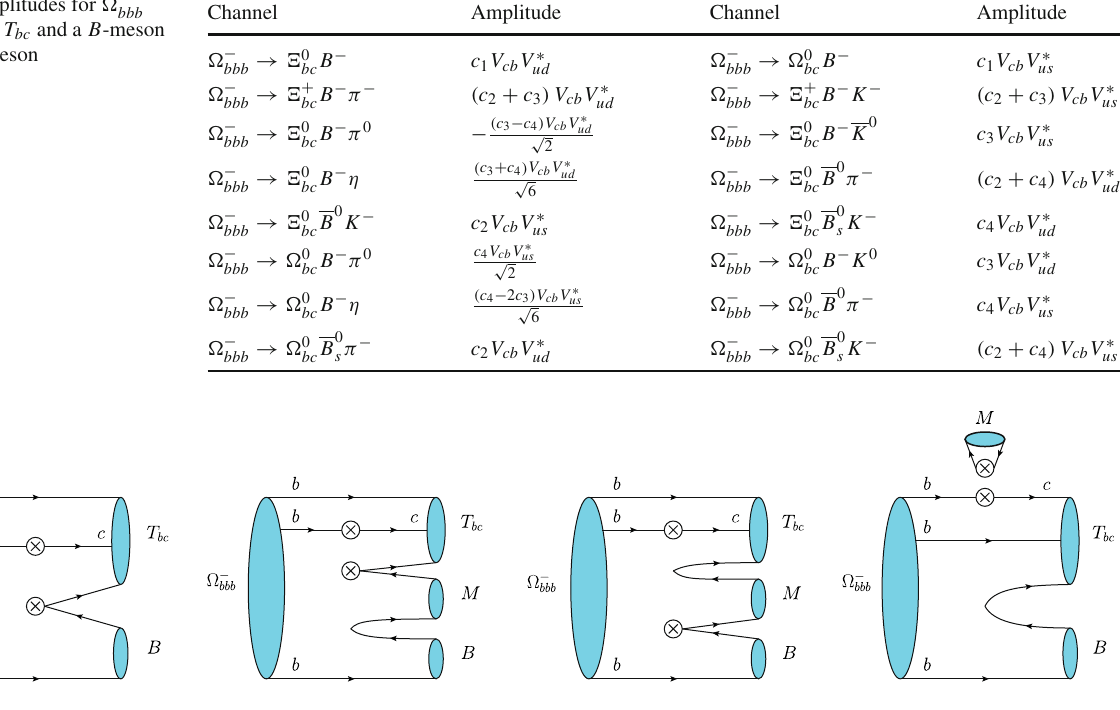
where the explicit expressions for O i can be found in Ref. [58]. Penguin operators in Eq. (24) are not suppressed, they behave as 3 representation in the SU(3) group,